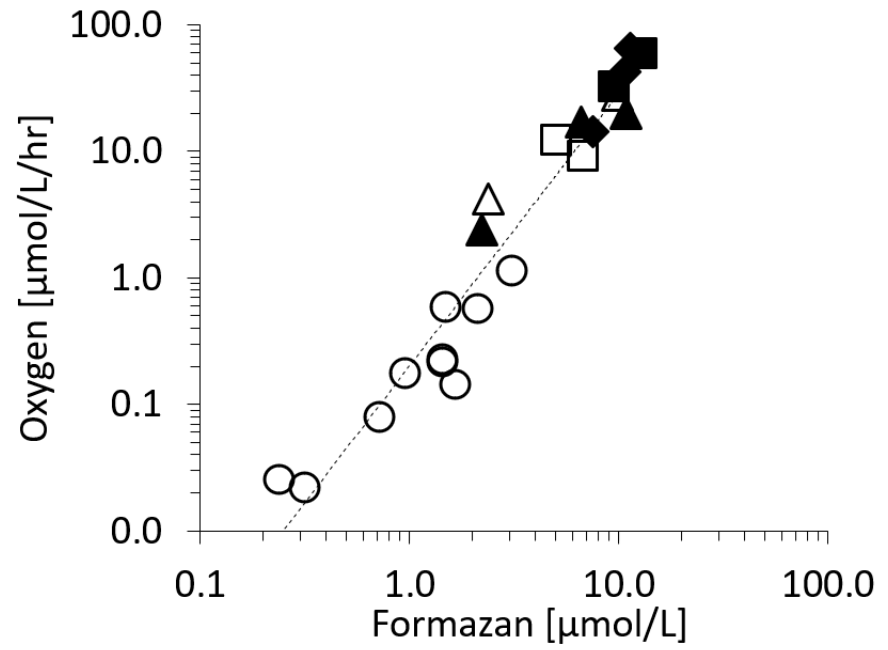
18 ◦ C, (cid:78) 20 ◦ C, (cid:4) 25 ◦ C, (cid:35)